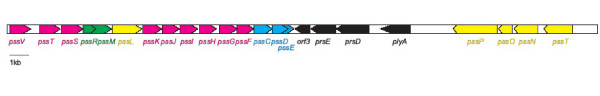
Genetic organization of the pss gene clusters of R. leguminosarum based on GenBank accesions: AF028810, X98117, Y12758, X99850, AF040104, AY237541, AF014054, X98117, AF067140 and AF402596. Colour marks of the pss genes respond to colours of the proteins shown in Fig. 3